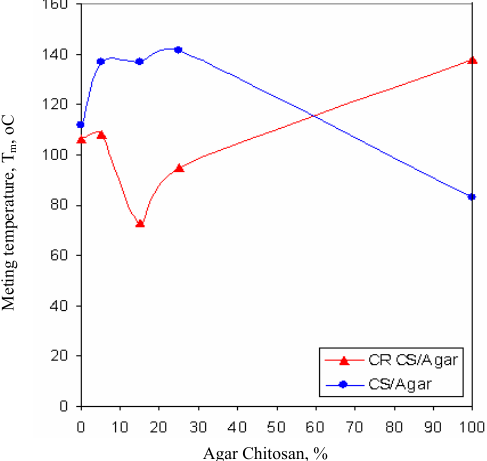
Figure 8. Variation of melting temperature of non-crosslinked CS/Agar blended films and their crosslinked CS/Agar counterparts with the agar